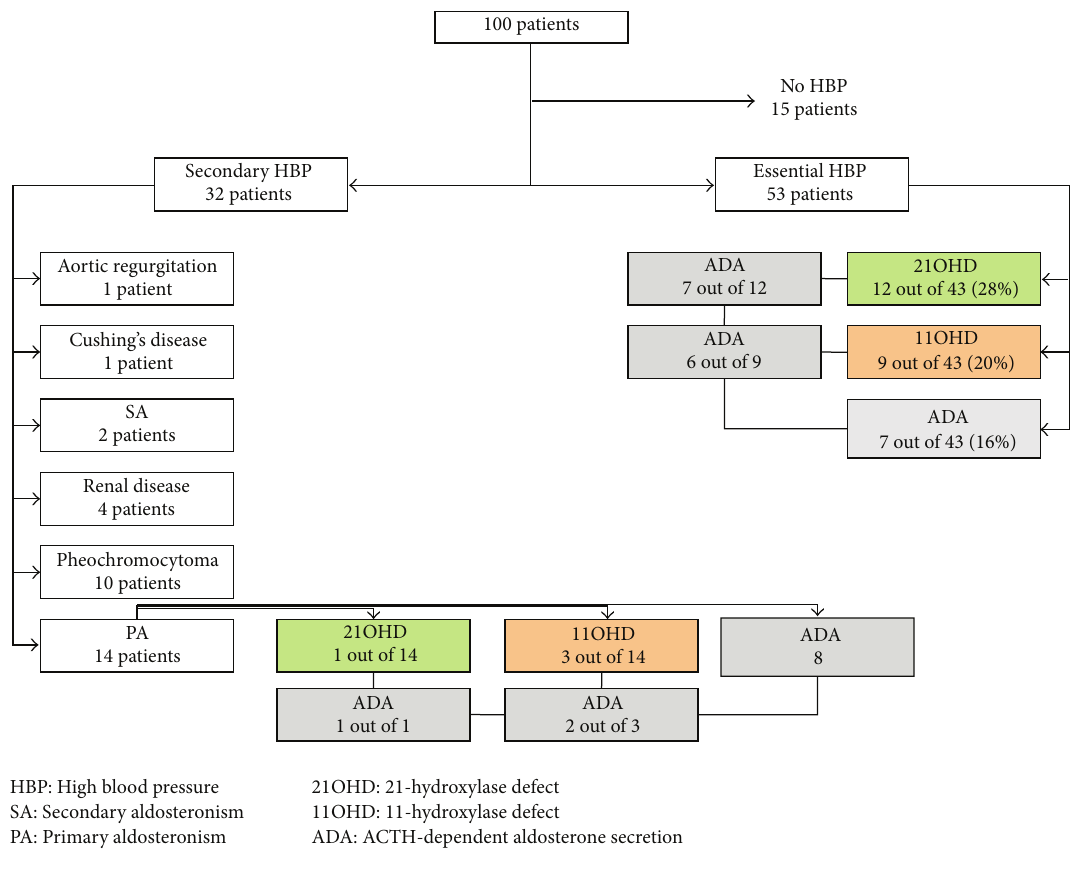
Figure 3: Abnormal steroidogenesis in patients with essential high blood pressure and in those with primary hyperaldosteronism. ADA, ACTH-dependent aldosterone secretion; HBP, high blood pressure; PA, primary aldosteronism; SA, secondary aldosteronism; 21OHD, 21- hydroxylase defect; 11OHD, 11-hydroxylase